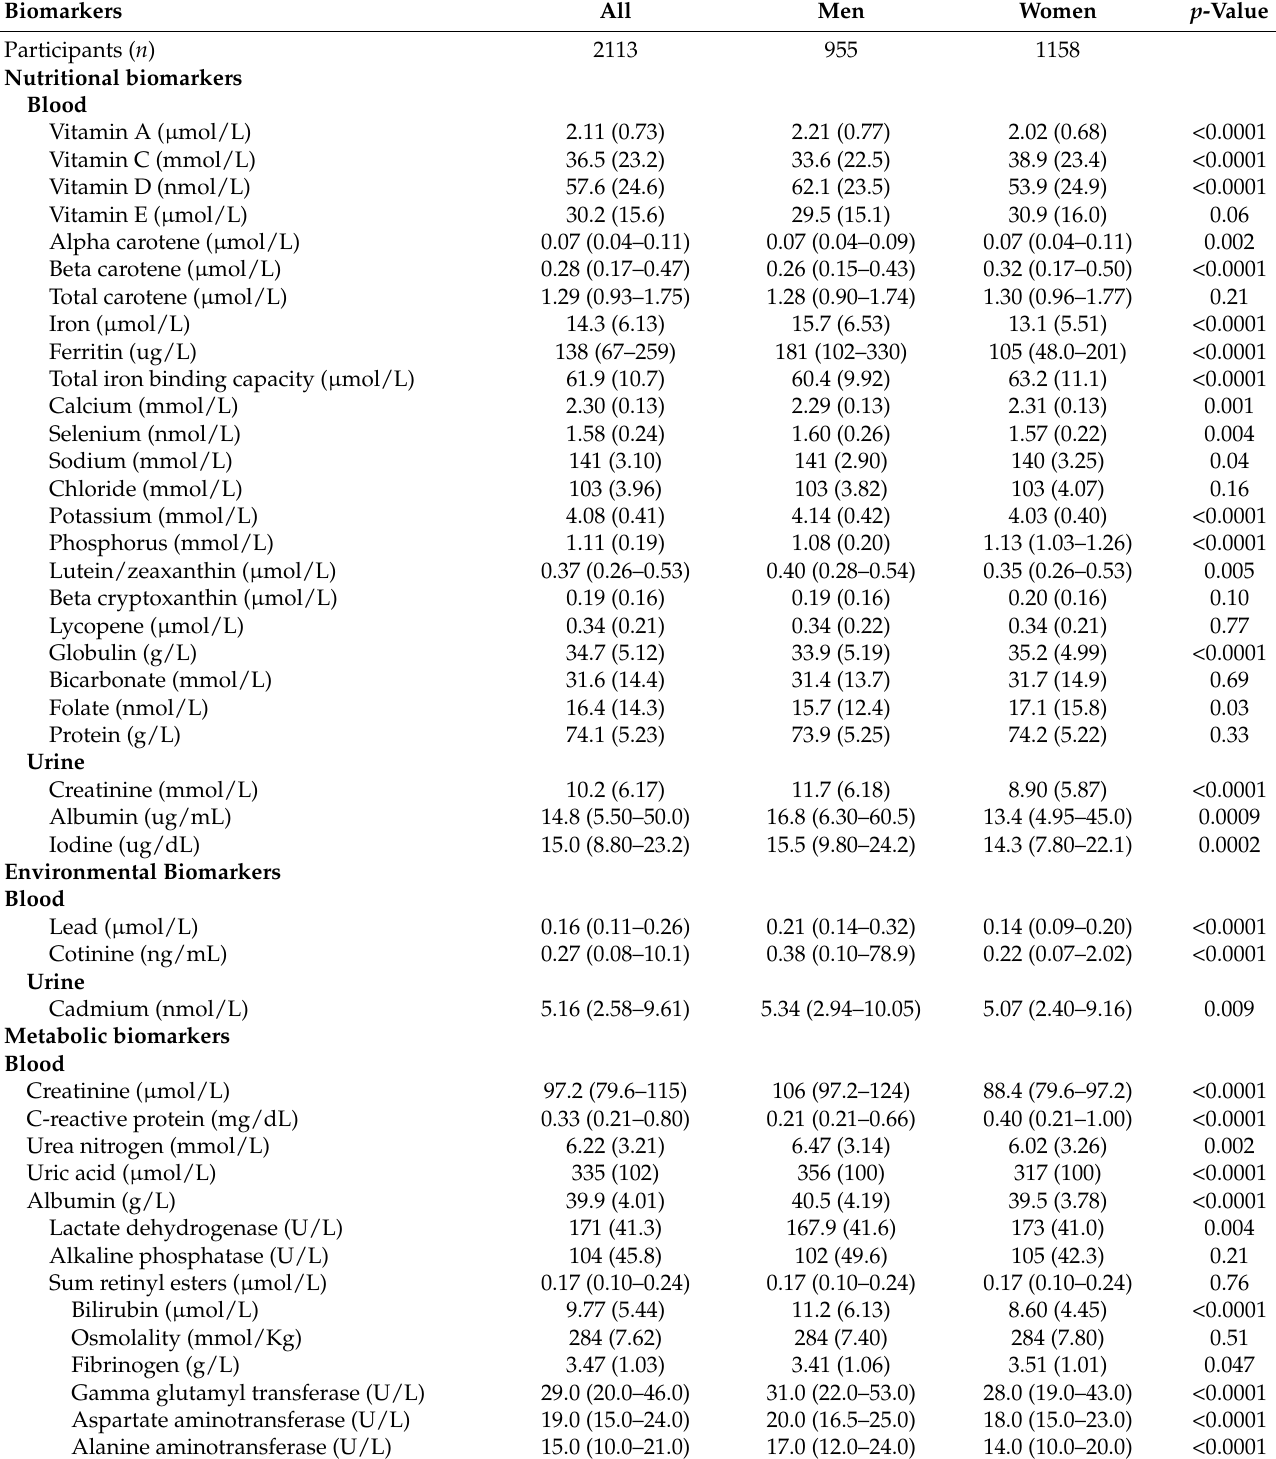
Table 1. Baseline biomarker characteristics of US adults with diabetes aged over 20 years in NHANES III